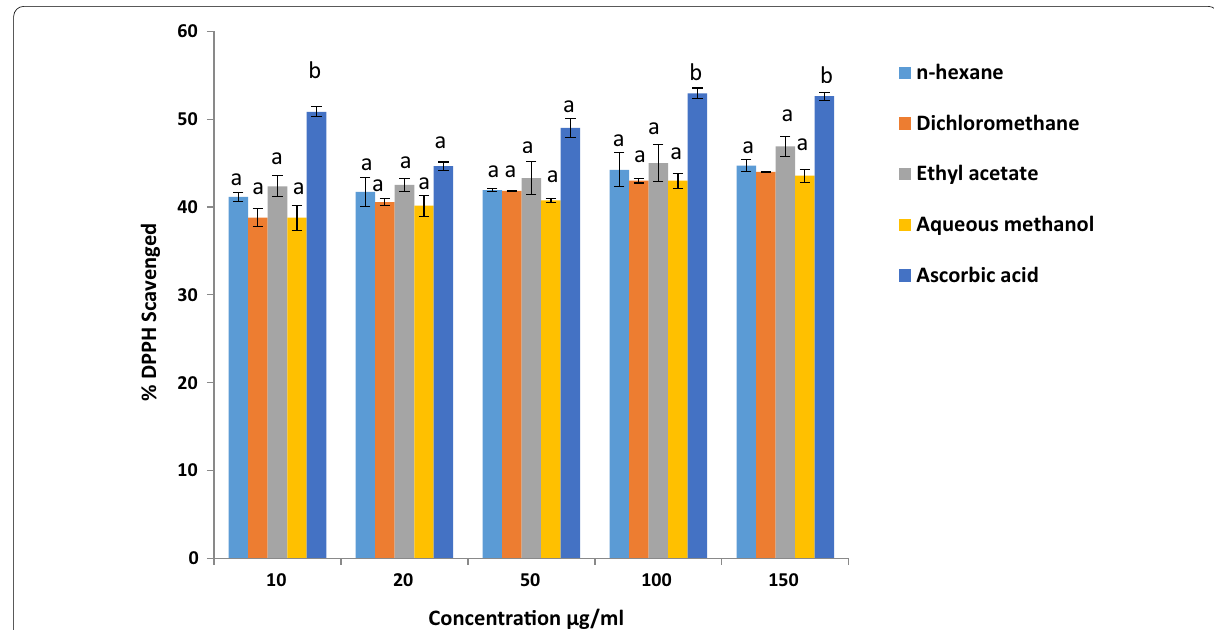
Fig. 3 DPPH radical scavenging activity of fractions from leaf extract of C. albidum. Values are expressed as mean on same grouped bars show that values for the fractions are significantly different ( p < 0.05) from each other. This figure shows the ability of different fractions obtained from leaf extract of C. albidum to scavenge DPPH radical at different concentrations